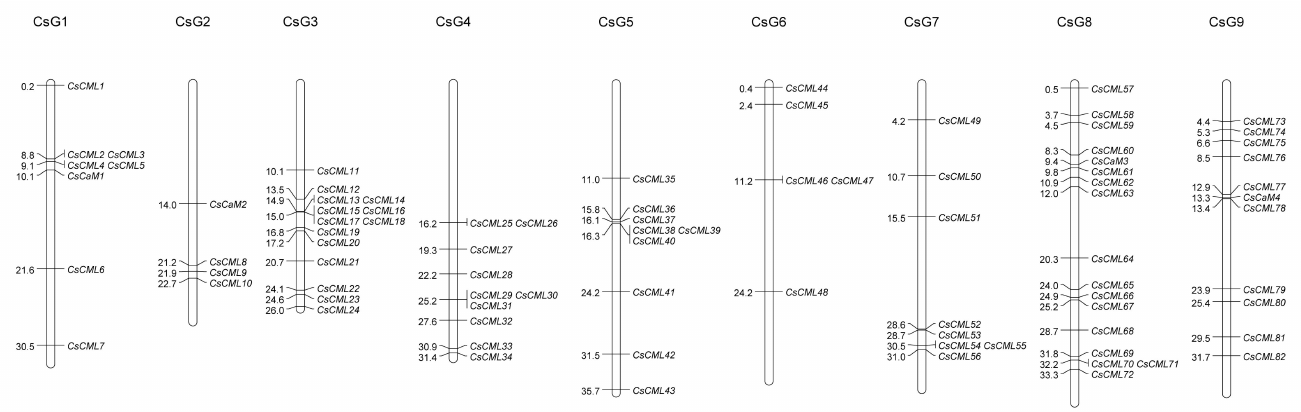
Figure 2. Sequences analysis of CsCaM/CML genes. Gene structures ( a ), motifs ( b ), and cis-acting regulatory elements ( c ) of CsCaM/CML gene family members were analyzed and depicted.